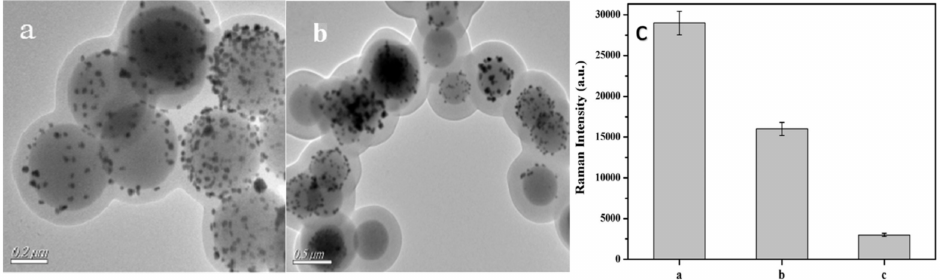
Figure 10. The TEM images of SiO 2 /Ag/MIPs with different shell thickness: 40 nm ( a ), 170 nm ( b ) and ( c ) the SERS detections of different thicknesses of SiO2/Ag/MIPs to the same concentration of R6G at 10 − 6 mol L − 1 (40 nm ( a ), 100 nm ( b ), 170 nm ( c ))